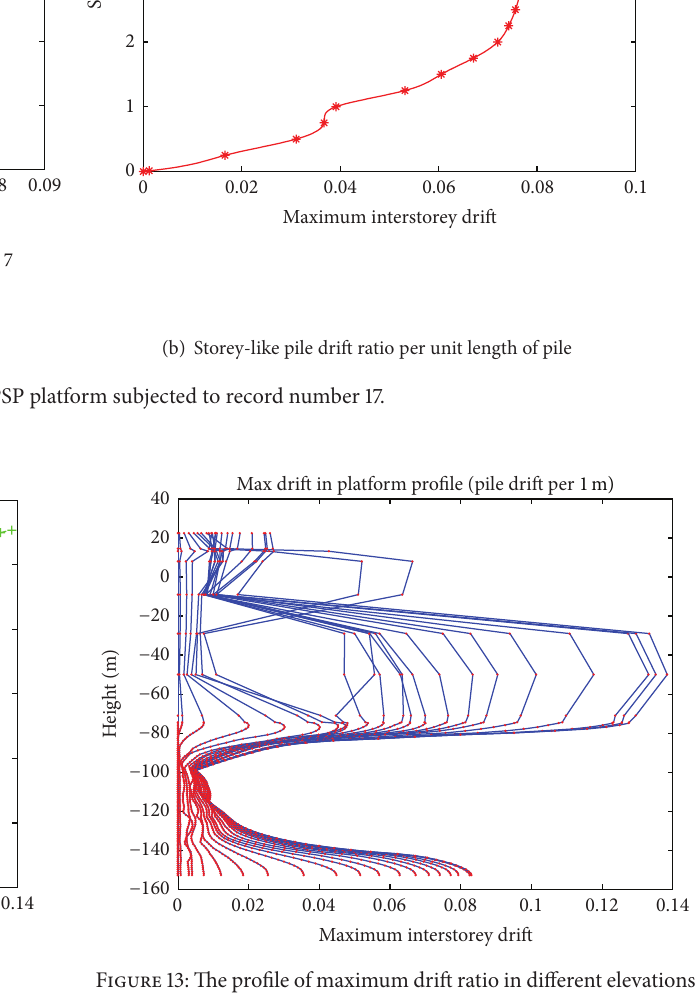
Figure 13: The profile of maximum drift ratio in different elevations of platform from pile tip up to deck